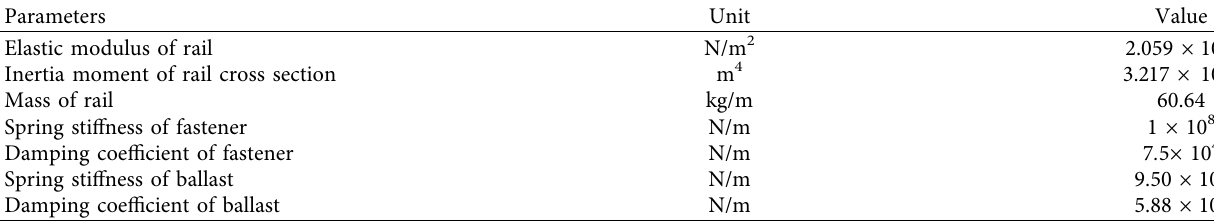
Table 3: The main parameters of the ballasted track.